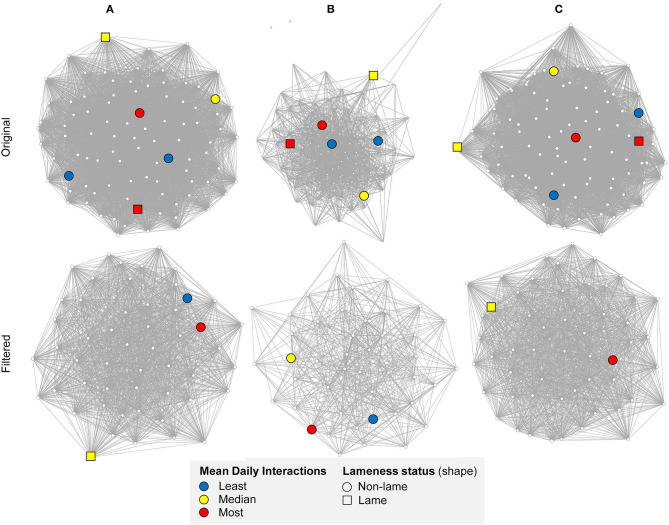
Undirected original and filtered (by mean degree) networks on a randomly chosen day, 01/10/2014, in (A) the full barn, (B) feeding zone, and (C) non-feeding zone, showing mean daily interactions between cows (n = 92 in original networks). Thicker edges indicate a higher number of daily interactions. The Fruchterman-Reingold layout algorithm was used to determine the node positions; unconnected vertices are repelled. The highlighted illustrative subset of cows correspond, respectively to the least (blue, cow ID = 3124 and 3317), median (yellow, cow ID = 3132 and 635), and most (red, cow ID = 2273 and 2266) mean daily interactions, with squared nodes representing lame cows. A clearer network structure is shown after filtering, with a more uniform distribution of interactions in the main barn and the non-feeding zone in comparison to the feeding zone. Created in RStudio using the “vegan” package (68, 69, 75).